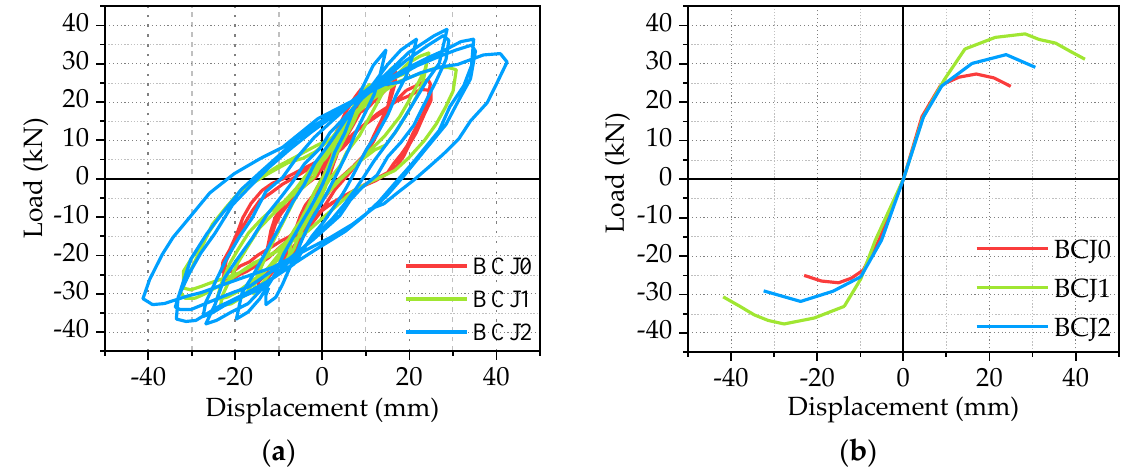
Figure 9. The effect of volume ratio of steel fiber: ( a ) Hysteretic curve; ( b ) Skeleton curve.